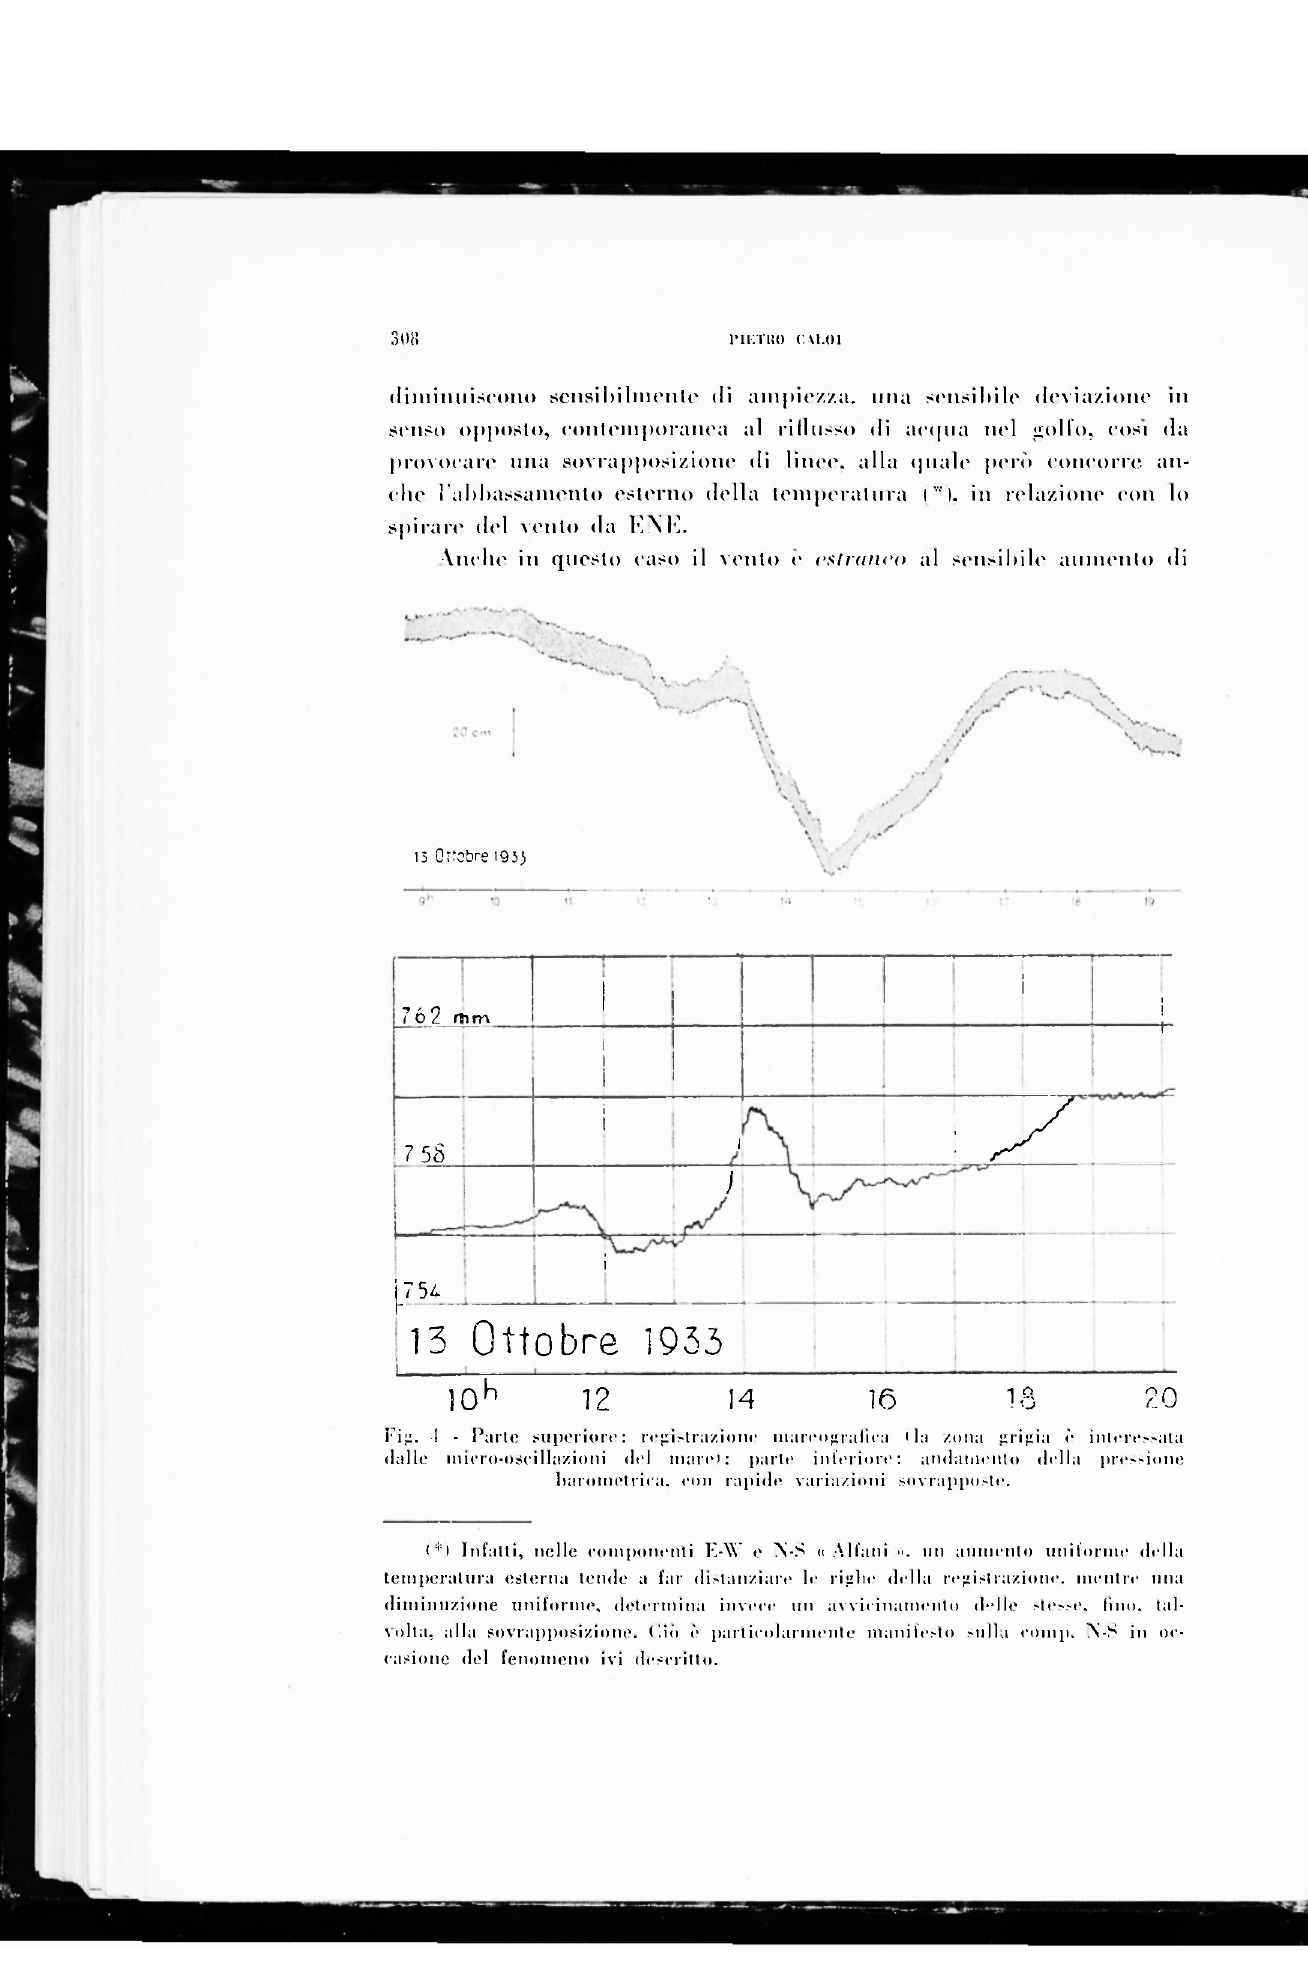
Fig. 4 - Parte superiore: registrazione mareografìea (la zona grigia è interessata dalle micro-oscillazioni del mare); parte inferiore: andamento della pressione barometrica, con rapide variazioni